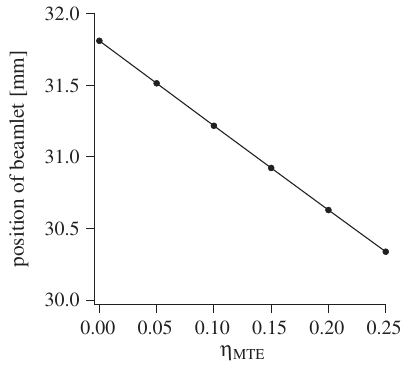
FIG. 12. Beamlet ’ s position as a function of MTE efficiency with ¼ 6 . 255 (the total beam intensity is 3 . 28 × 10 13 p) h 2 < 0 and Q ; 0 x and parallel plates electric boundary conditions.